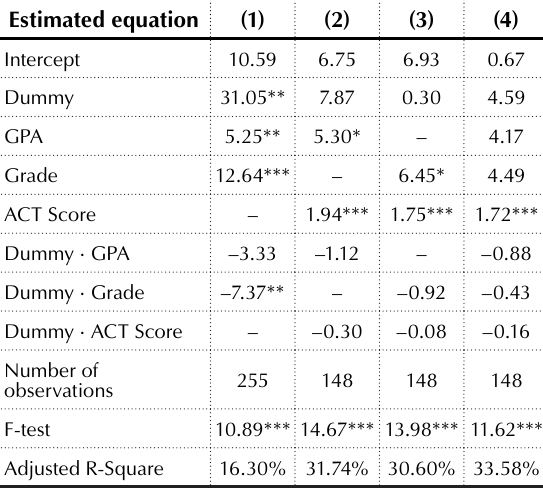
Table 3. Regression results with the first mid- term exam scores (EXAM1) as the dependent variable Estimated